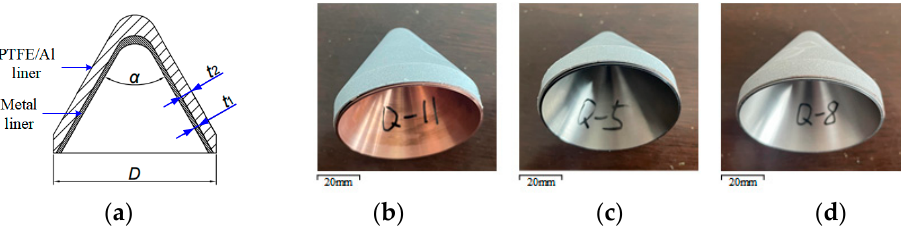
Figure 2. Schematic structure and sample of composite liner: ( a ) schematic structure; ( b ) reactive material–Cu liner; ( c ) reactive material–Ti liner; ( d ) reactive material–Al liner.